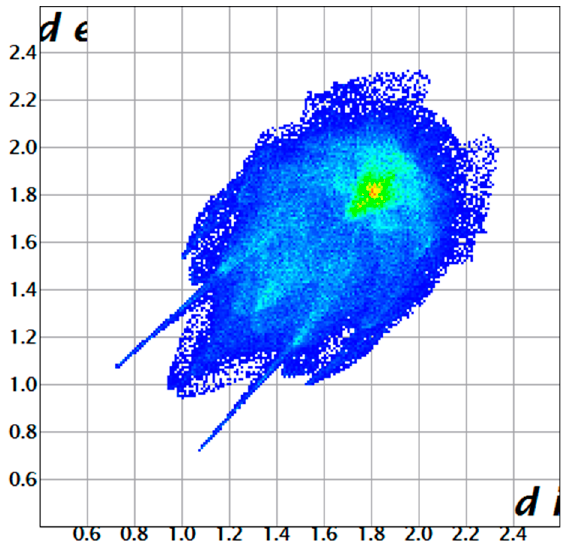
Figure 7. The fingerprint plot of the Genkwanin crystal structure from the Hirshfeld surface. The distinctive features are two spikes from the strong hydrogen bond; a red orange region at around 3.60 Å from the numerous π - π interactions (and a significant contribution from by the π -stacking). The somewhat broadened point between the two arms at 2 Å is characteristic of H-H interactions.